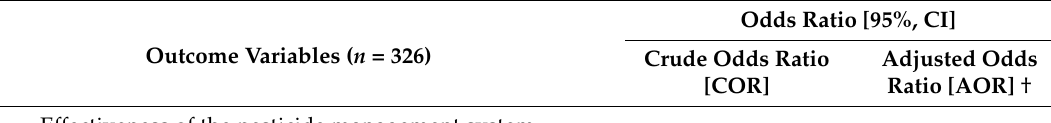
Table 9. Differences in practice of using pesticides in Hungary and